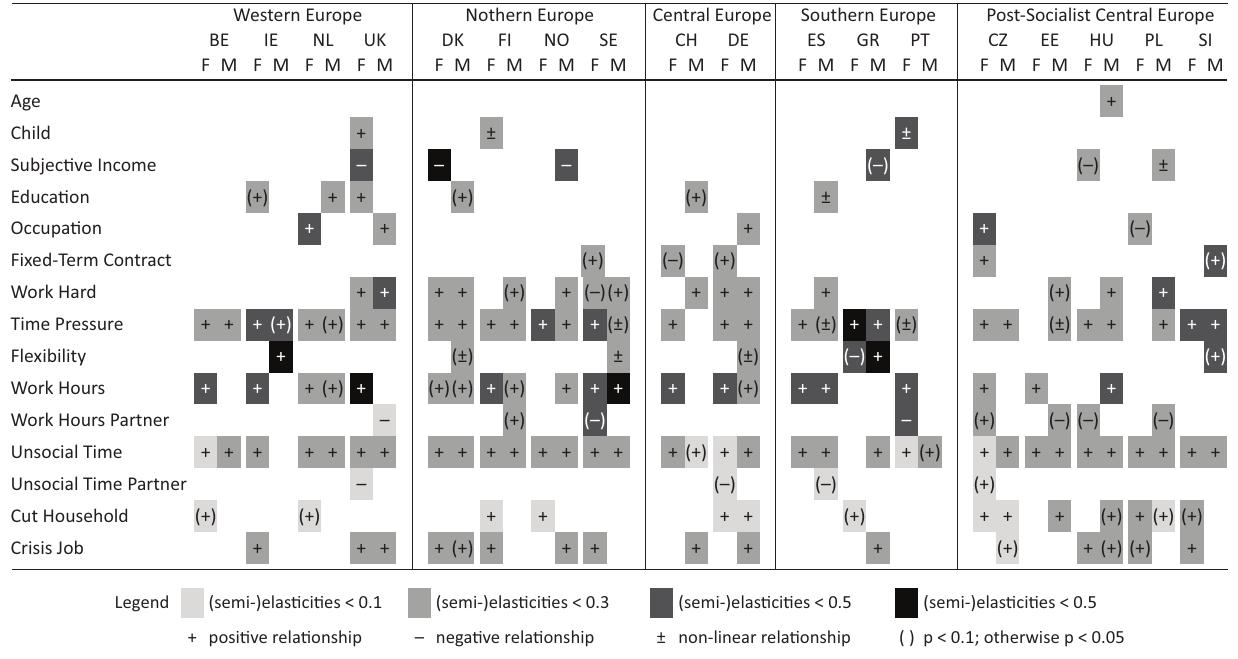
Figure 1. Graphical representation of effect size by country group, country and